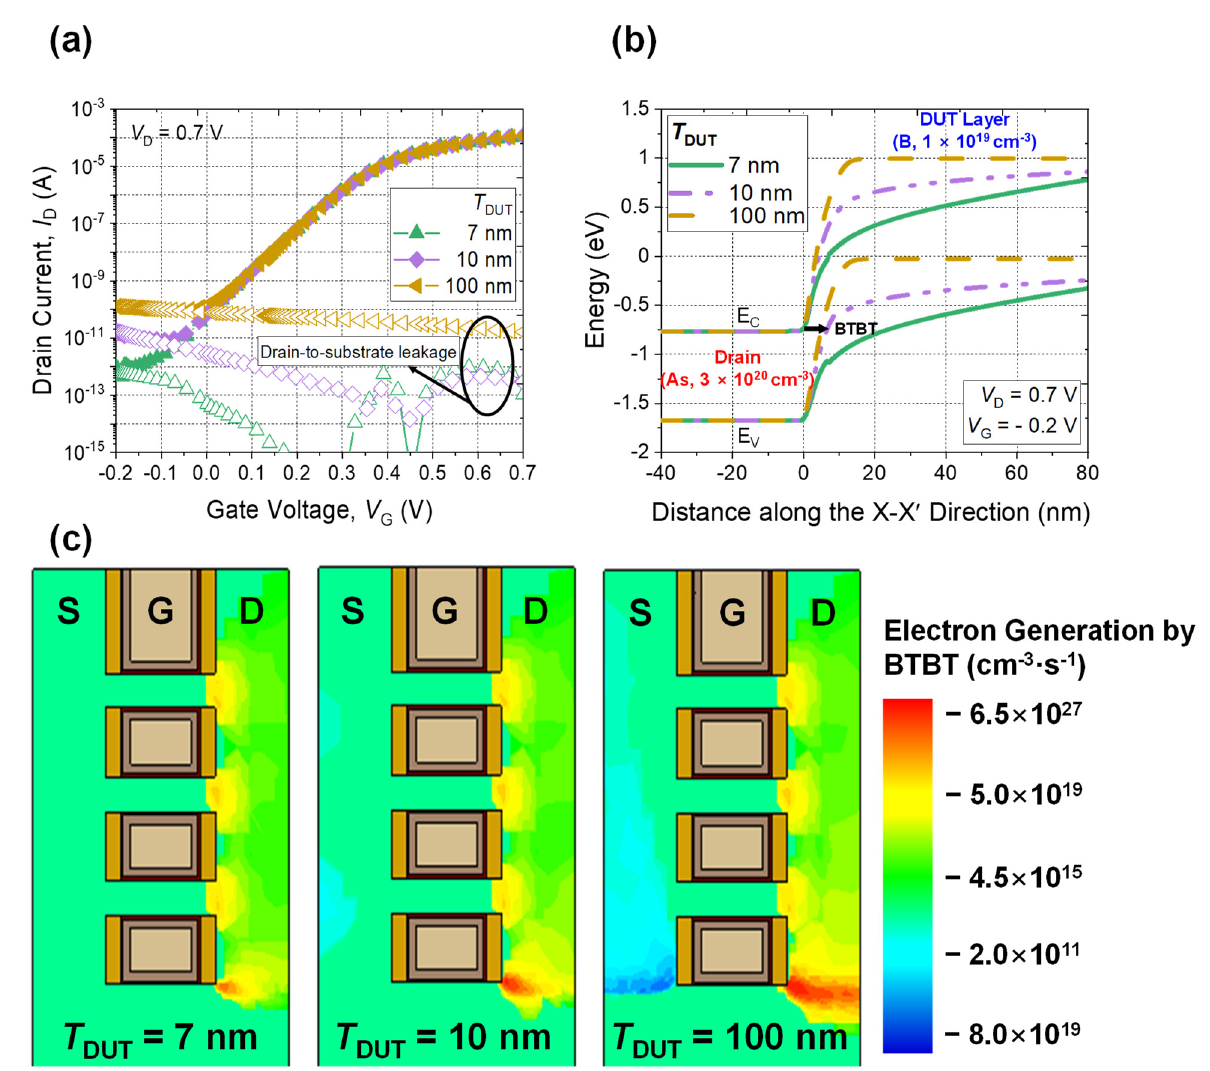
Figure 6. ( a ) Simulated I D – V G characteristic and ( b ) extracted energy band diagram of NS FETs (X–X ′ direction in Figure 2c) with various thicknesses of DUT layers greater than 7 nm. ( c ) Electron generation rates with various T DUT .